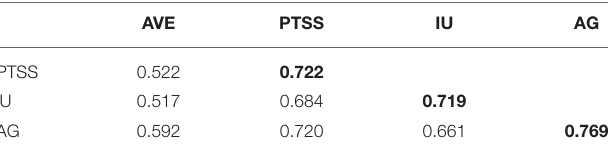
AVE, Average variance extracted; PTSS, Post-traumatic Stress Symptoms; IU, Illness Uncertainty; AG, Anticipatory Grief. The bold values indicate the square root of AVE for discriminant